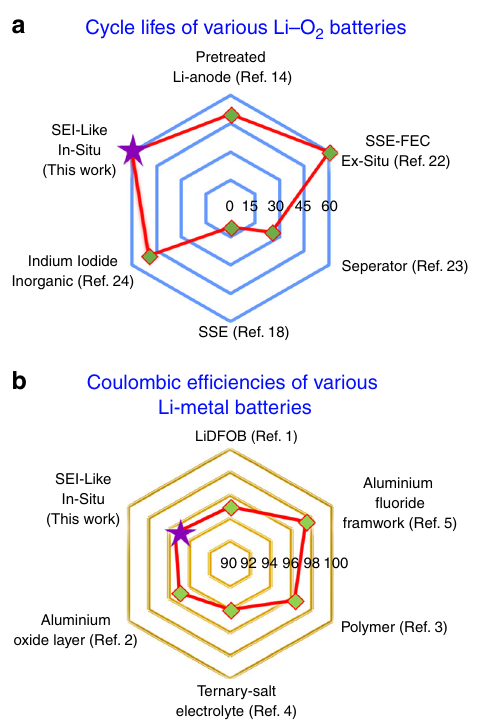
Fig. 9 Summary of the performance of recently reported interfacial engineering methods improving the Li metal anode. a Cycling performance of various Li-O 2 batteries. b Coulombic ef fi ciency of various Li-metal